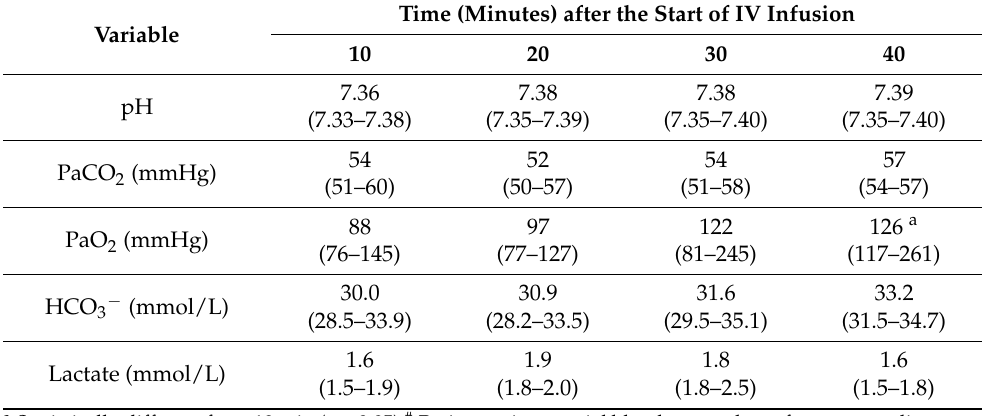
Table 2. Arterial blood gas variables for four # colts anaesthetised for 40 min with infusions of ketamine, medetomidine and midazolam as part of a balanced anaesthetic technique for surgical